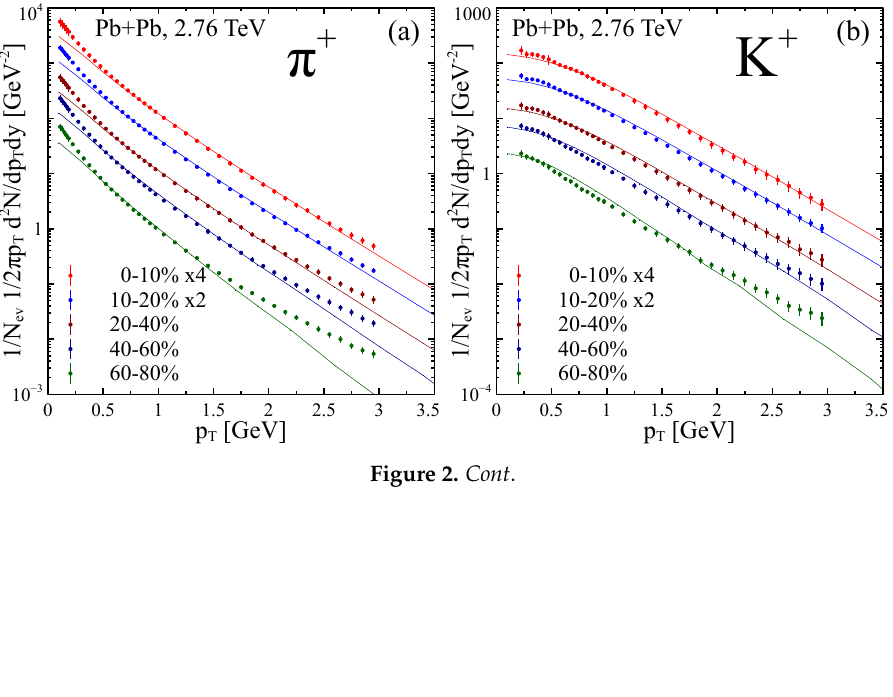
Figure 1. Coalescence parameter B 2 , measured by ALICE collaboration in Pb+Pb collisions at 2.76 TeV [1] (circles) is compared to the outcome of our hybrid (hydrodynamics + transport) approach calculation (lines) and to the same calculation without rescatterings, only with decays (dashed lines). Note that we do not apply coalescence model. Instead, we adopt the approach of [4], where deuterons are produced at particlization, similarly to hadrons, and rescatter in the hadronic stage. B 2